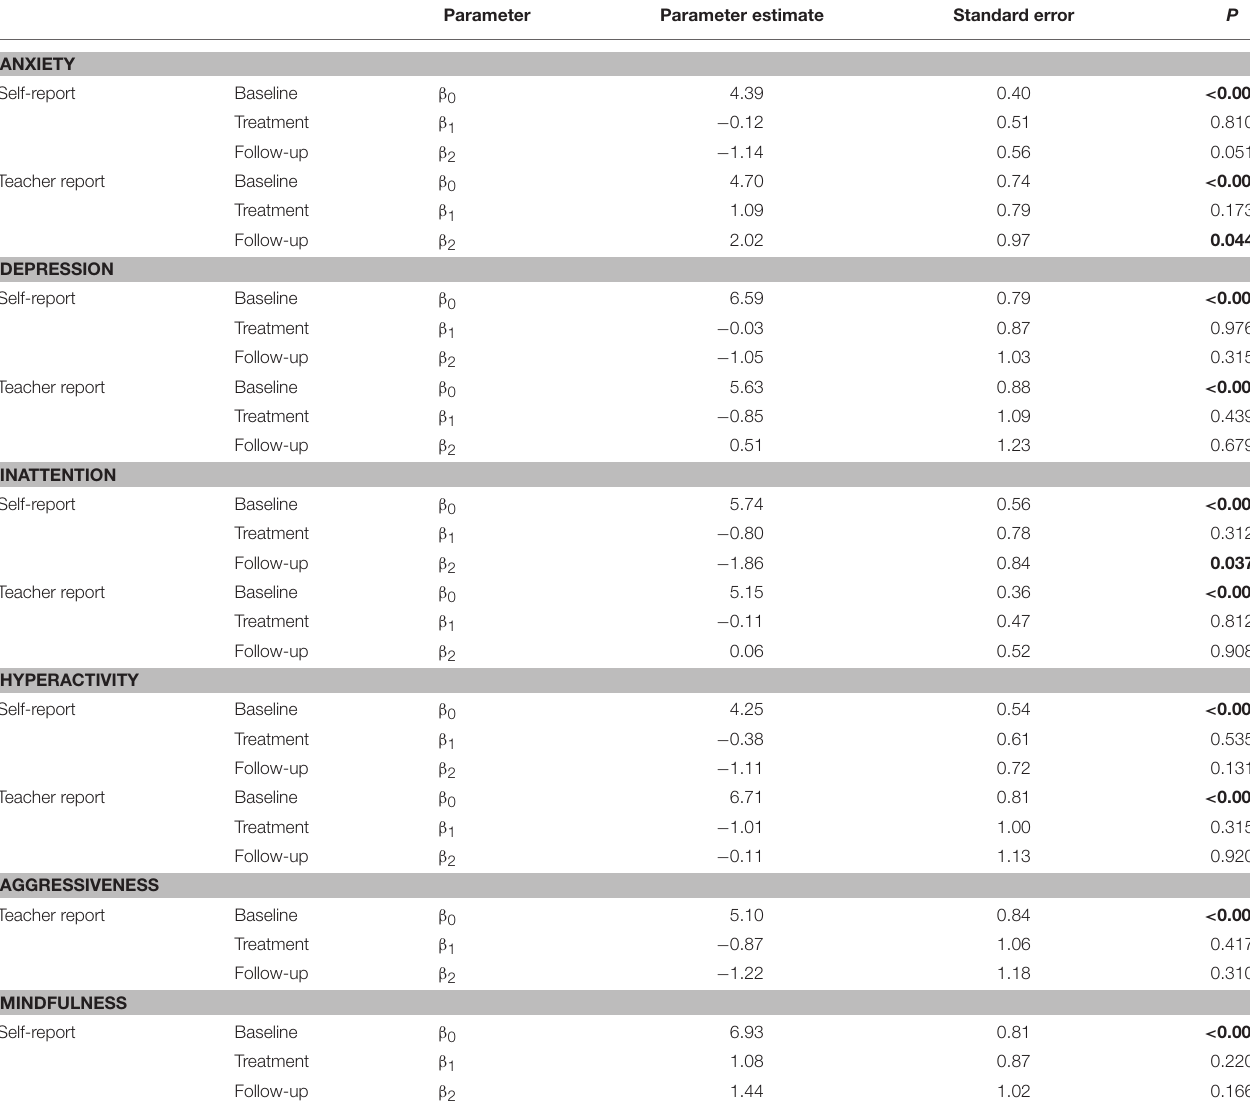
TABLE 3 | Results of empirical estimations of the case-specific effects using the basic three levels model for all variables for Group A